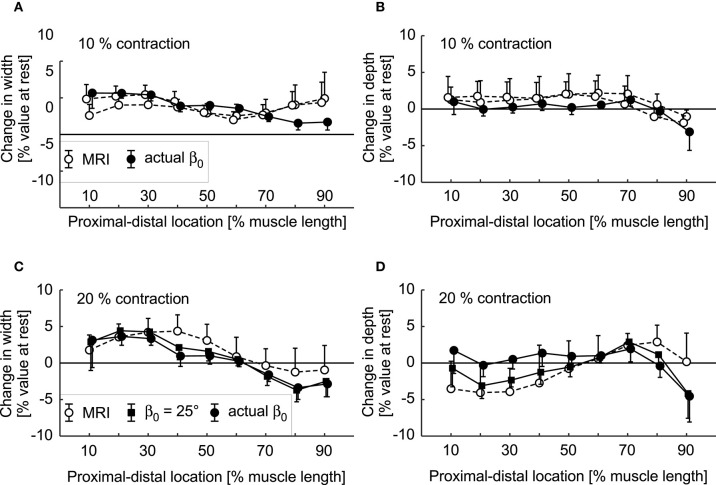
Change in muscle width (A,C) and depth (B,D) during fixed-end contractions of the medial gastrocnemius. Data are shown for 10% (A,B) and 20% plantarflexion torques (C,D) as predicted by the simulations (black squares for β0 = 25° and black circles for actual β0) and as measured from anatomical MRI scans (white circles). Circles and error bars are the means and standard deviations of the data/models from four participants. The two sets of white circles in the top panels are repeated MRI measurements. The bottom panels show changes in depth and width for simulations where the initial fibre orientations (not activated) were derived from DTI (black circles), and where the initial fibre orientations were set to 25° (black squares) so that the simulated fibre orientations at 20% activation were a closer match to the orientations measured with DTI at 20% plantarflexion torque.